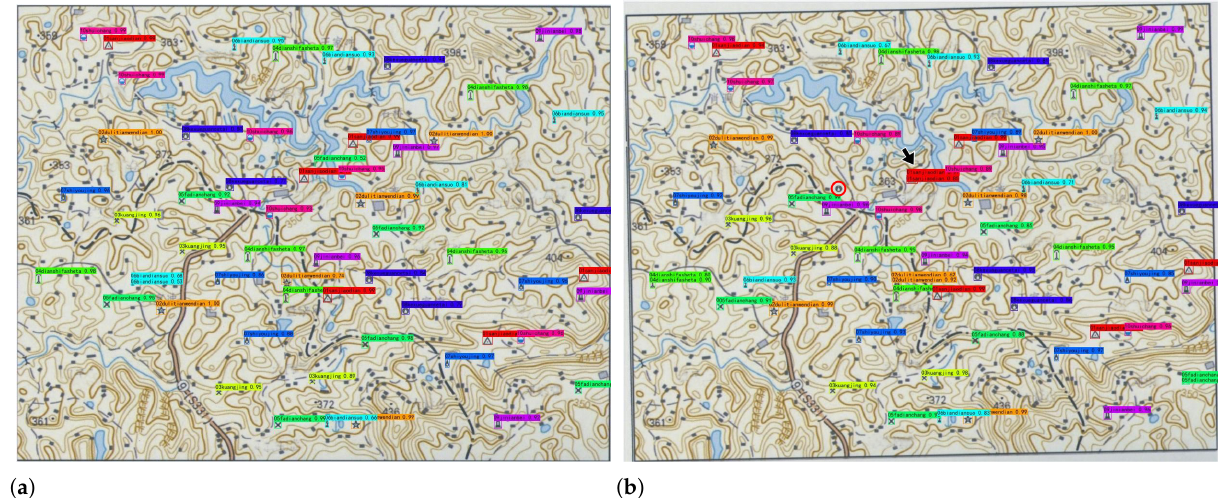
Figure 20. Results obtained by the proposed ASPP-YOLOv4 for Map F of size 1241 × 955 pixels. ( a ) Original image and ( b ) the image skewed during scanning. The red circle indicates missed recognition.